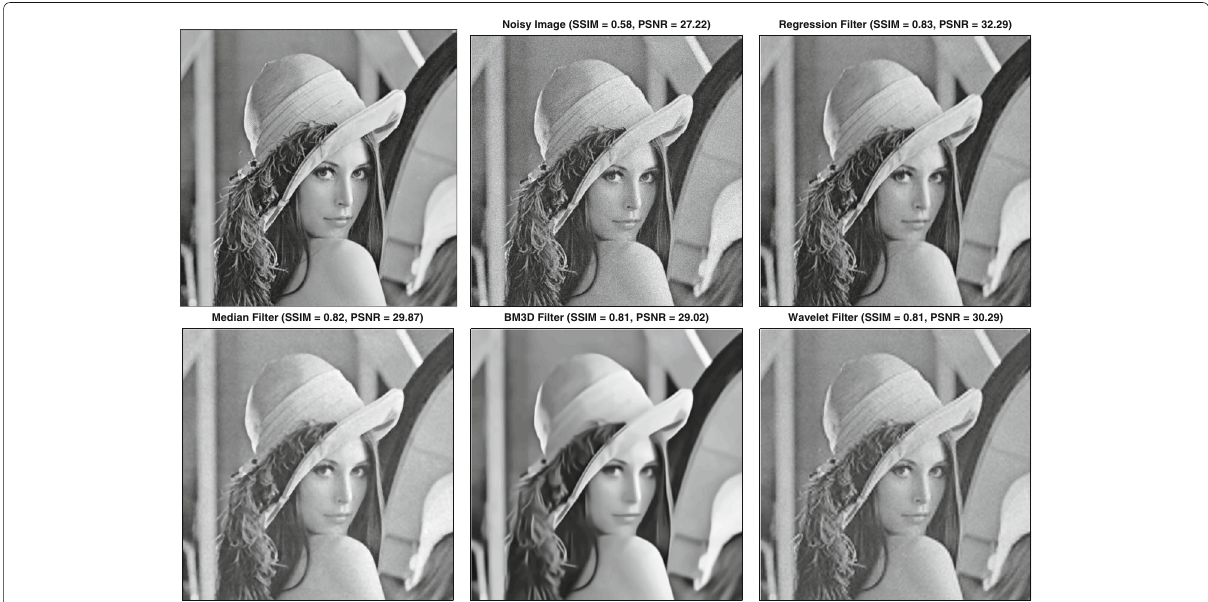
Fig. 1 Applied Poisson noise. From left to right: a clean Lena, b noisy image, c denoised image using our L 2 regression filter, d denoised image using median filter, e denoised image using BM3D, and f denoised image using wavelet filter